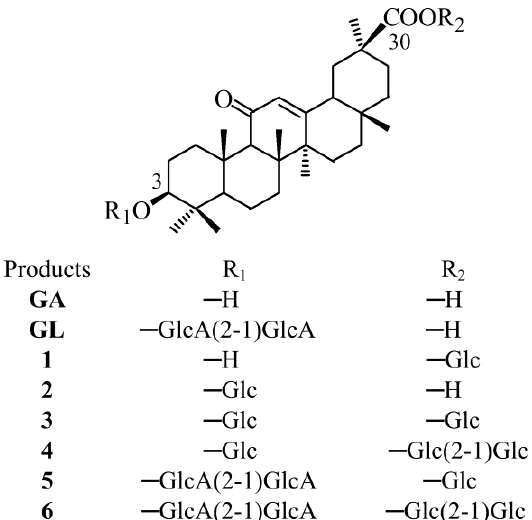
Figure 1. Structures of GA, GL and the respective glycosylated products. Glc and GlcA represented the glucose and glucuronic acid moiety, respectively.